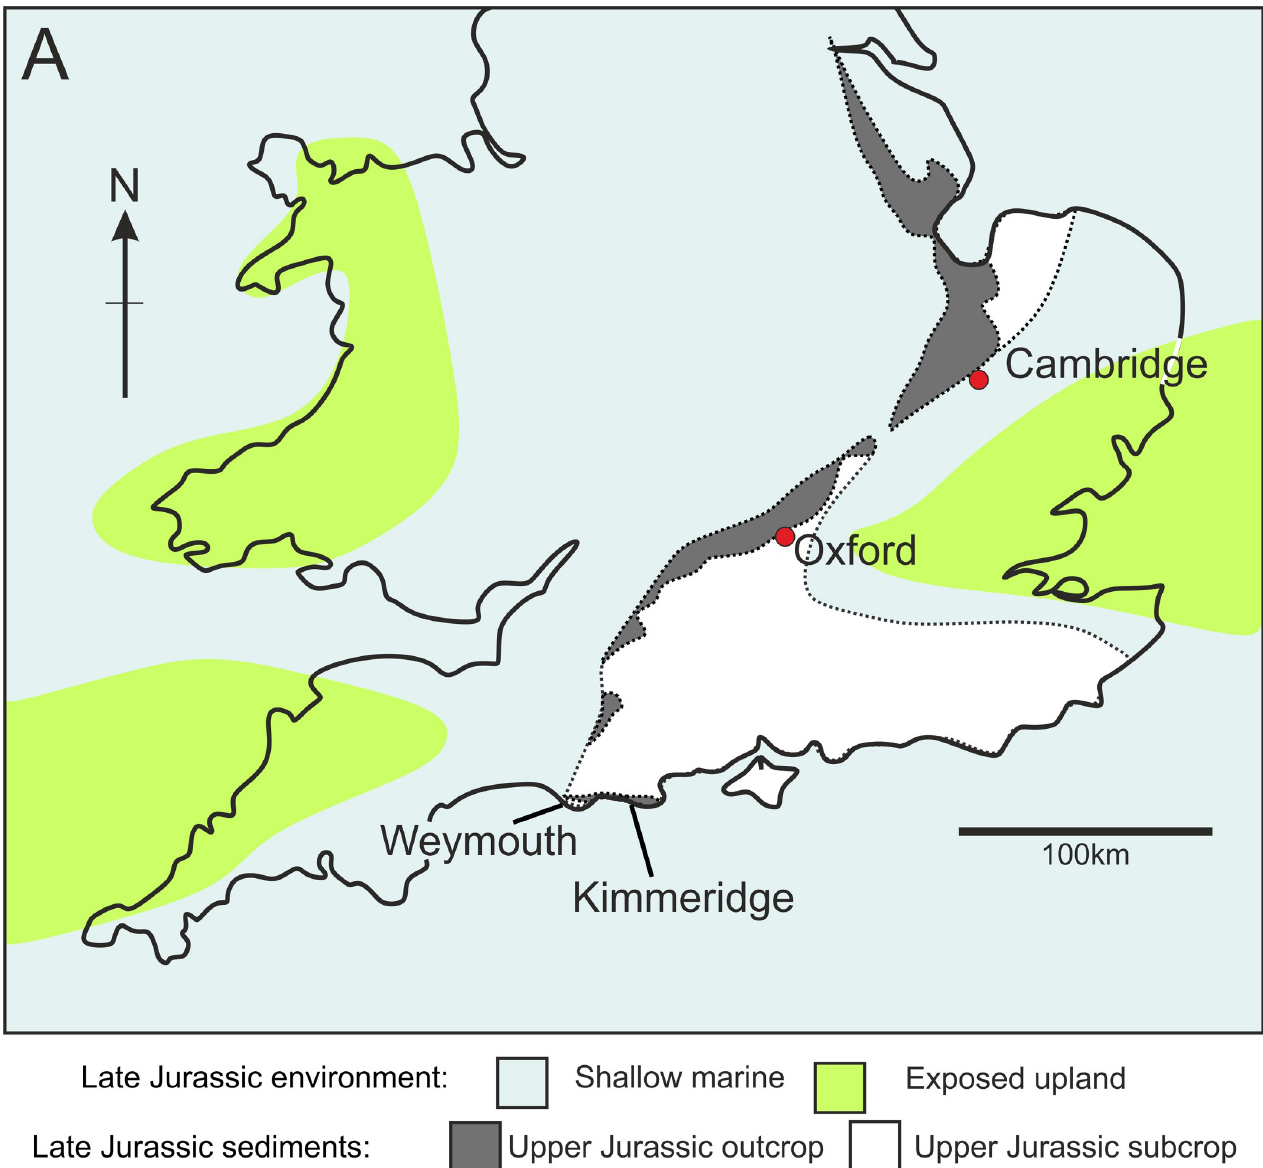
Fig 1. A, Outcrop and subcrop map of the onshore Upper Jurassic Kimmeridge Clay Formation, showing the locality of Kimmeridge on the English South Coast, and sea coverage over the United Kingdom during the Late Jurassic. Outcrop and sea coverage data after Martill et al . [21], and Foffa et al .